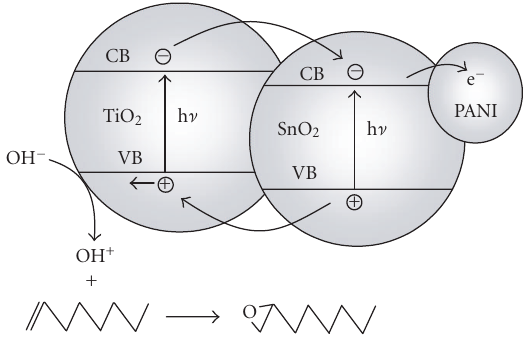
Figure 8: The proposed mechanism of photocatalytic epoxidation of 1-octene over PANI-SnO 2 − TiO 2